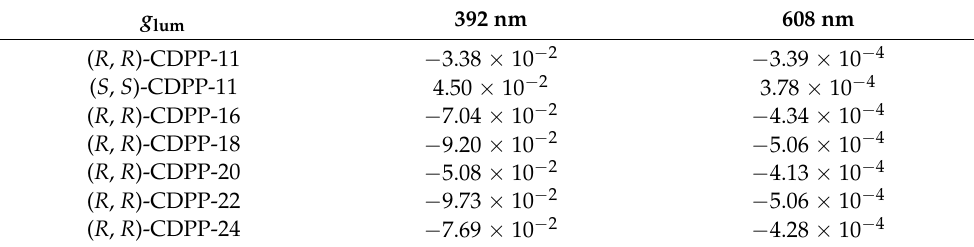
Table 1. The g lum of ( R , R